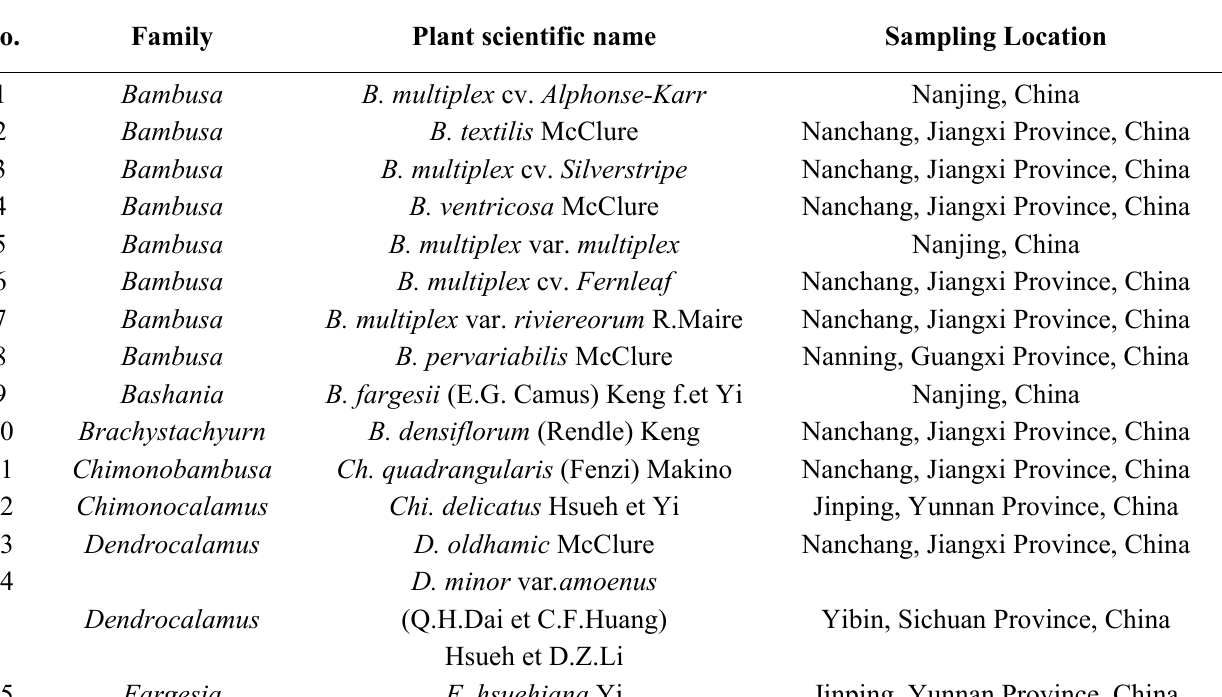
Table 1. Investigated leaves of 15 different species of